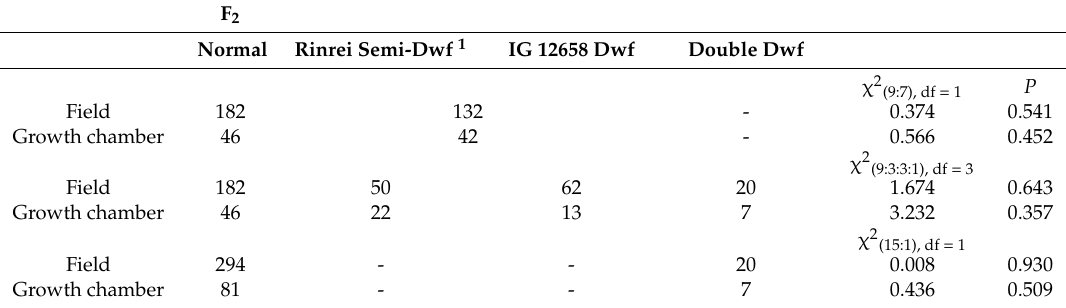
Table 3. Chi-square results for the F 2 population of the cross Rinrei × IG 12658 testing independence of the two recessive dwarfing genes (9:7), and the double dwarf hypothesis (9:3:3:1 and 15:1).